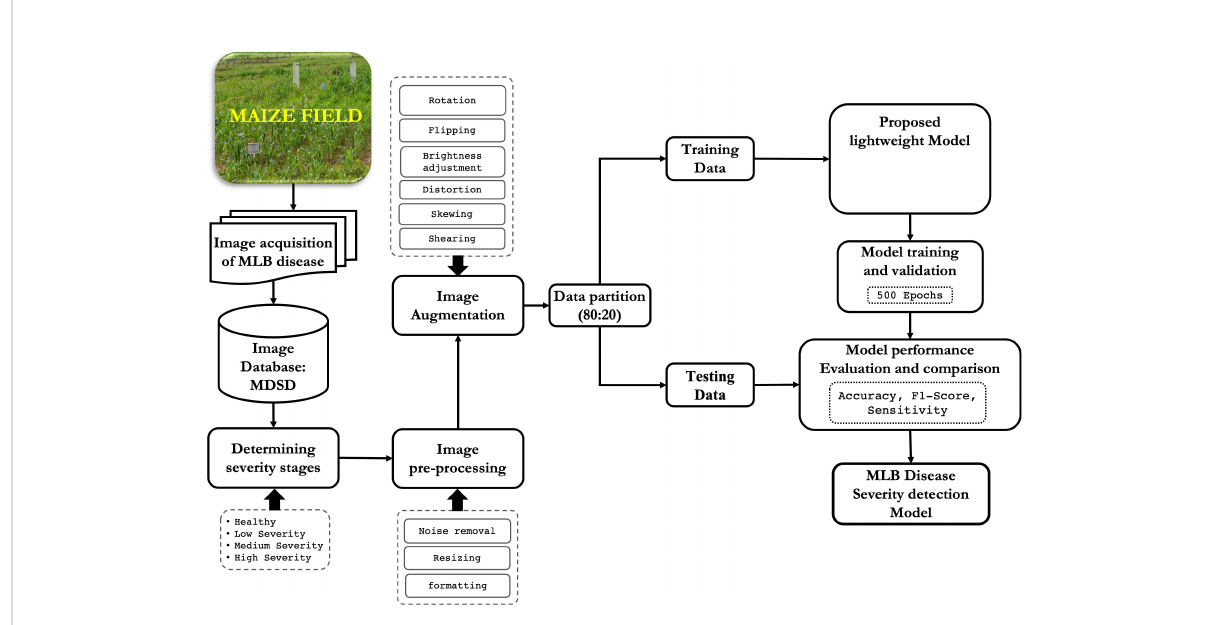
FIGURE 1 Overall framework of the proposed approach for recognition of severity stages of MLB